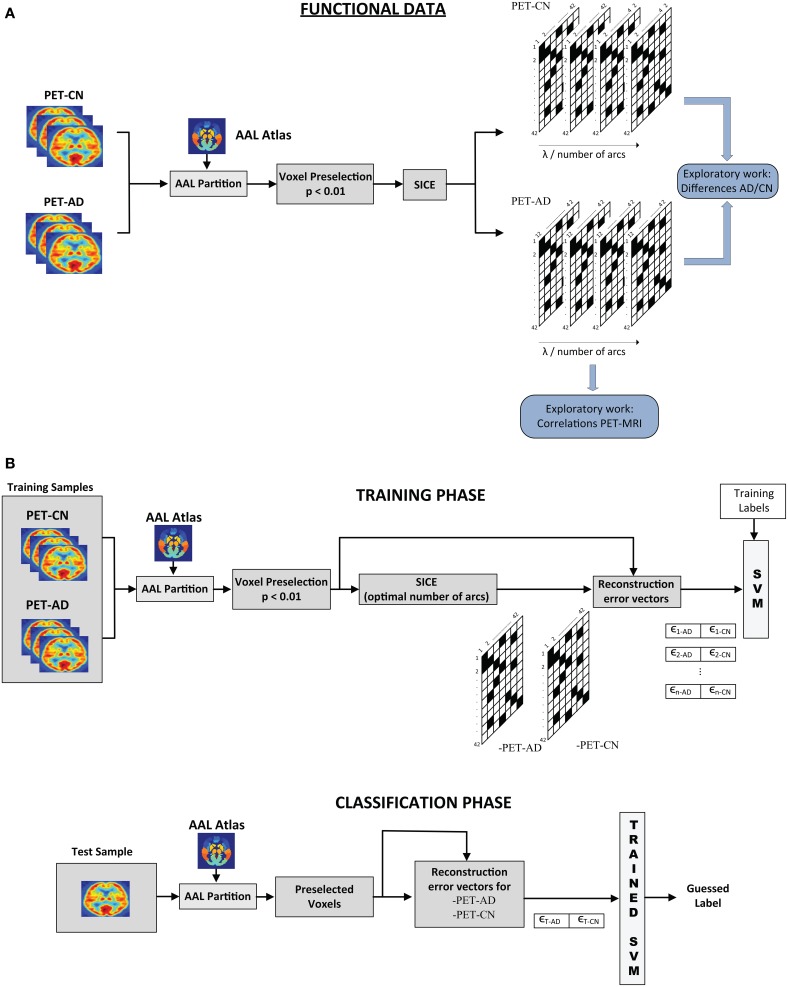
Scheme of the overall SICE-based process (Functional Data). (A) Exploratory and (B) Classification processes.